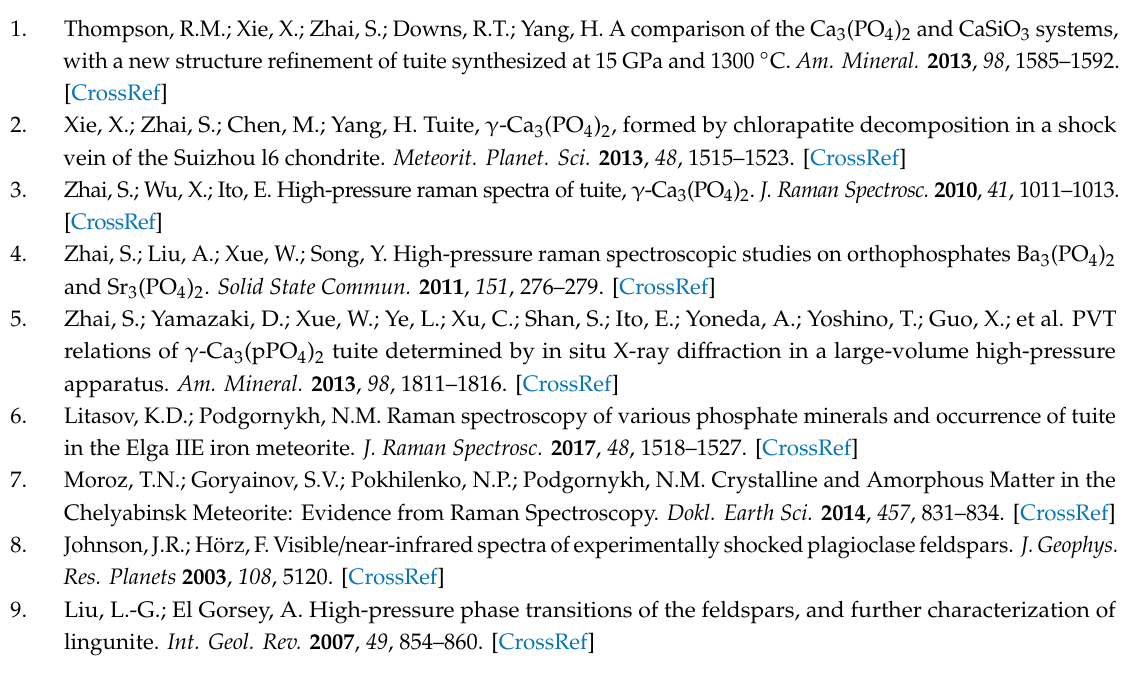
Table S1: Apatite EPMA; Table S2: Merrillite EPMA; Table S3: Plagioclase